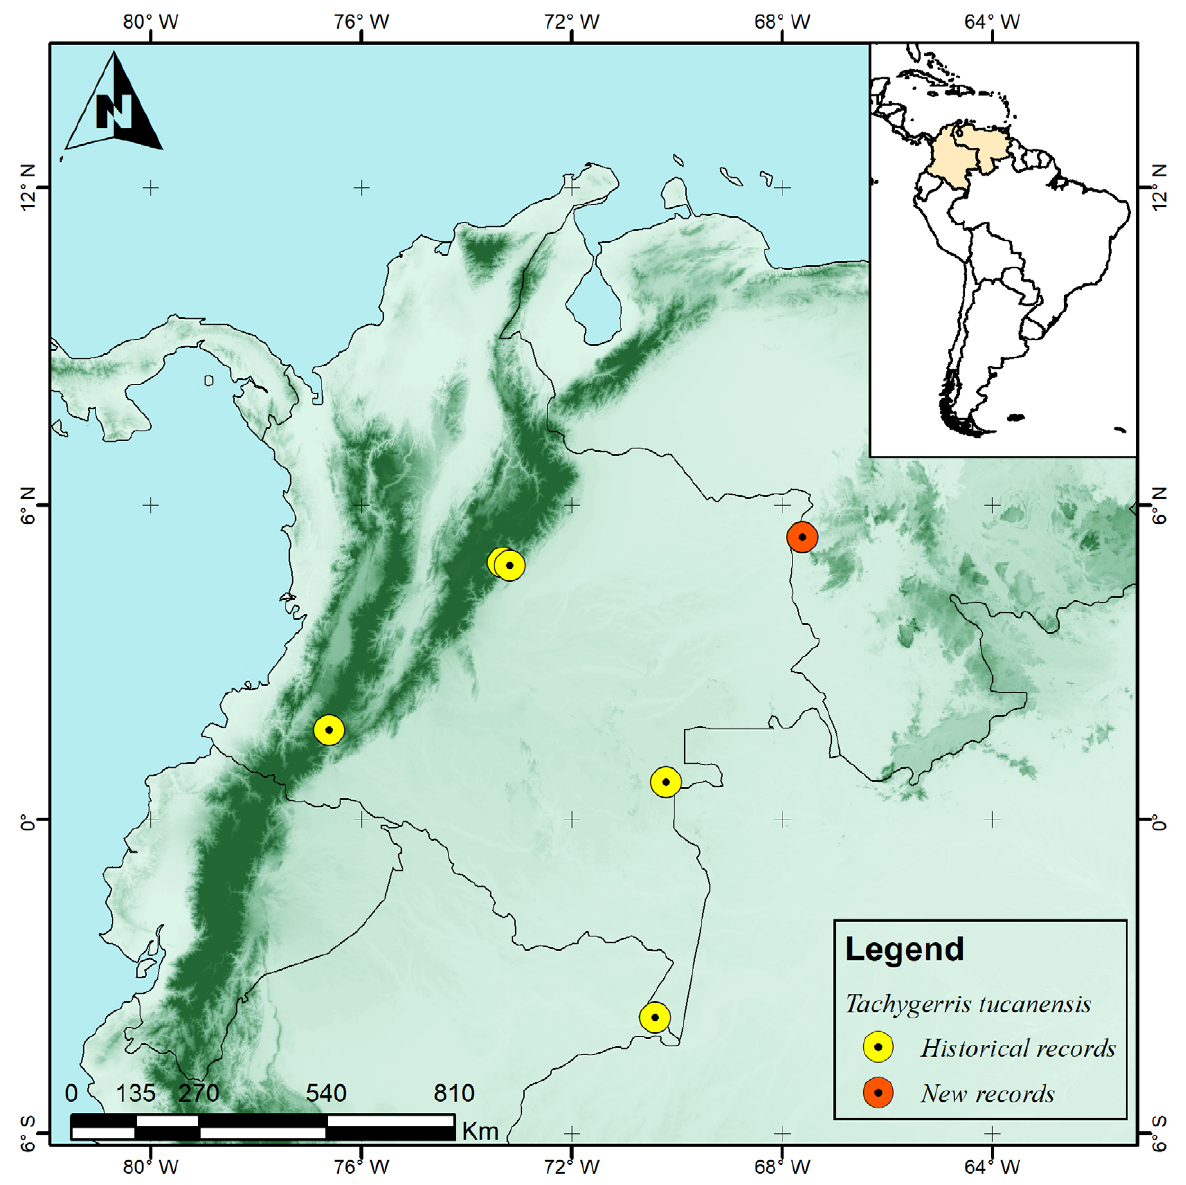
Figure 7. Historical and new records of Tachygerris tucanensis in the